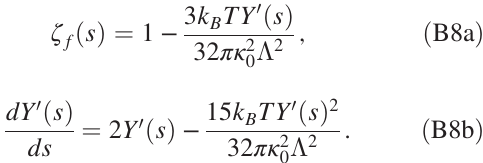
10 − 2 for two different choices of scaling exponents ζ FIG. 6. Renormalization group flows in thermalized flat sheets with a= l th ¼ l Þ ≡ 1 , and plots on the right correspond to ζ l Þ ¼ 1 − 3 k TY 0 ð l Þ = ð 32 πκ 2 0 Λ 2 Þ , which fixes Plots on the left correspond to ζ f ð f ð B κ 0 ð l Þ ≡ κ κ 0 ð l Þ and Y 0 ð l Þ obtained (a) from Eq. (B5) and (b) from Eq. (B8). (c,d) Scale 0 . (a,b) Renormalization group flows for l Þ and Y l Þ obtained by removing the scaling factors from κ 0 ð l Þ and Y 0 ð l Þ as dependence of renormalized elastic constants κ R ð R ð l Þ and Y l Þ are identical in (c) and (d), even though described in Eqs. (B3) and (B4). Note that the physical renormalized constants κ R ð R ð l Þ the flows of κ 0 ð l Þ and Y 0 ð l Þ in (a) and (b) depend on the precise choice of the scaling exponent ζ f ð